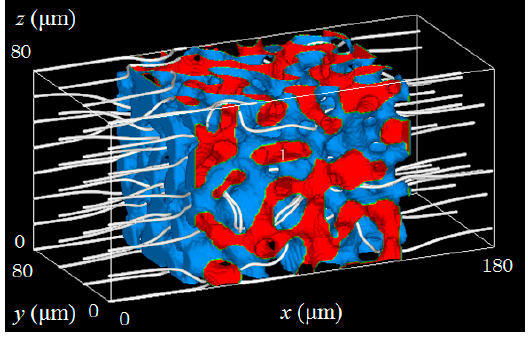
Figure 4. Flow field with streamline inside DPF, together with porous filter substrate.